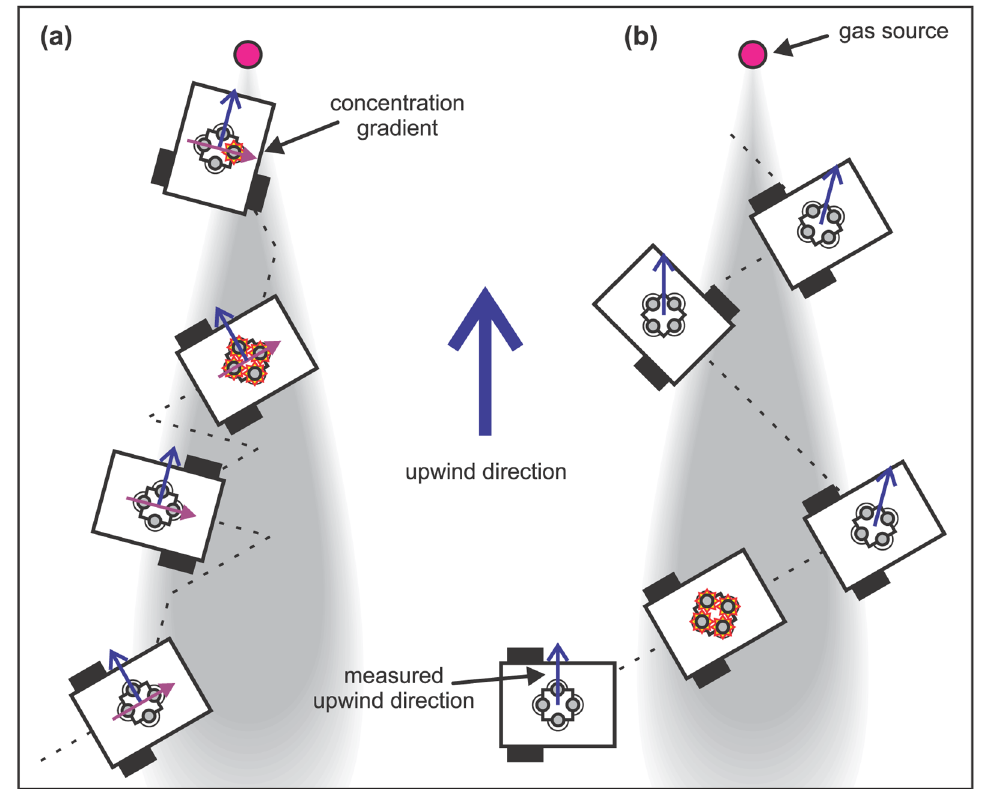
Figure 12 . (a) Step-by-step progress method suggested by Ishida et al. [76]. The wind direction was determined with an accuracy of 90 ◦ in this experiment. For clarity of the illustration, a larger step length (in proportion to the size of the robot) than used in the actual experiments is assumed in the sketch. (b) Zigzag approach method [76]. The wind direction was determined with an accuracy of 45 ◦ in this experiment. Possible trajectories are indicated on top of an idealised gas plume. A star around a sensor indicates that this sensor detects the target